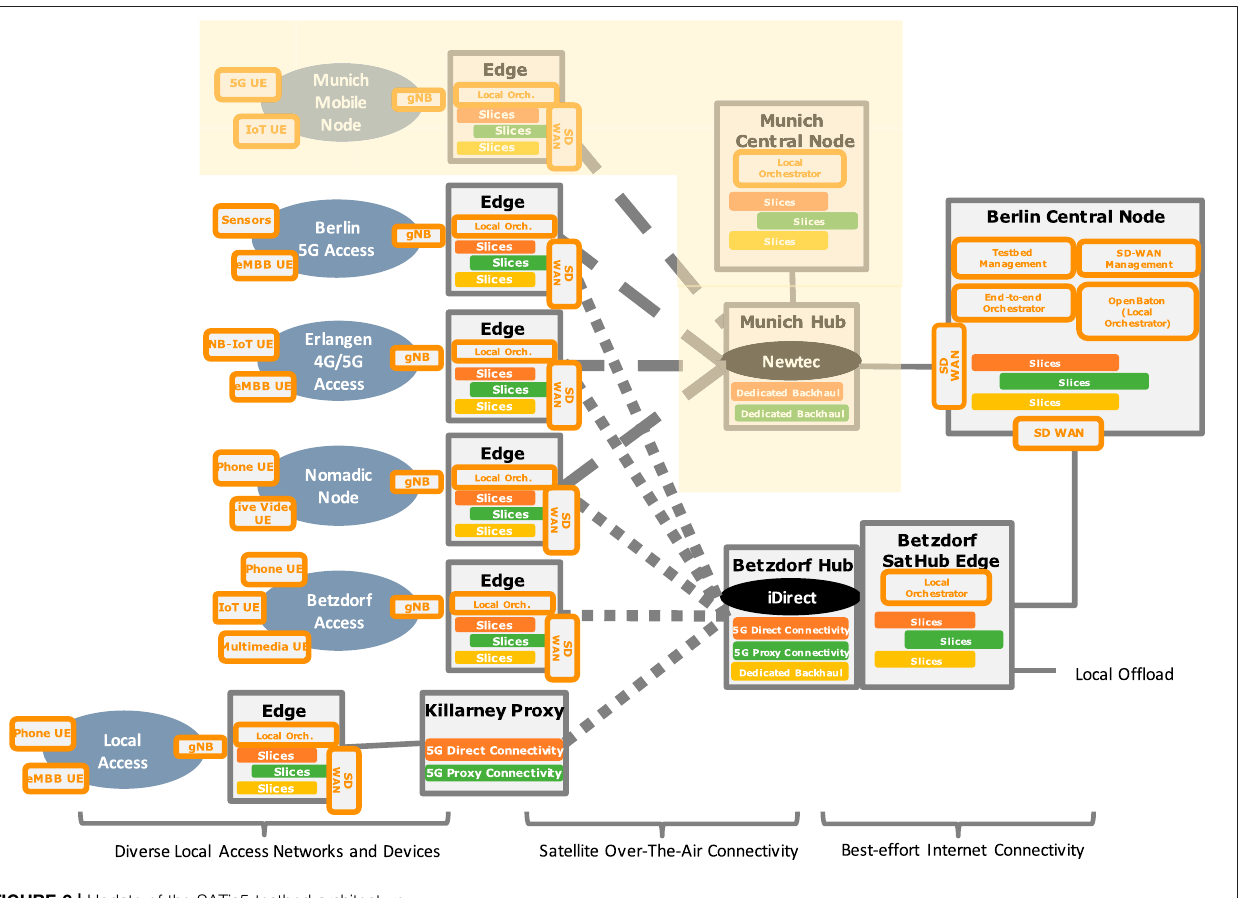
FIGURE 2 | Update of the SATis5 testbed